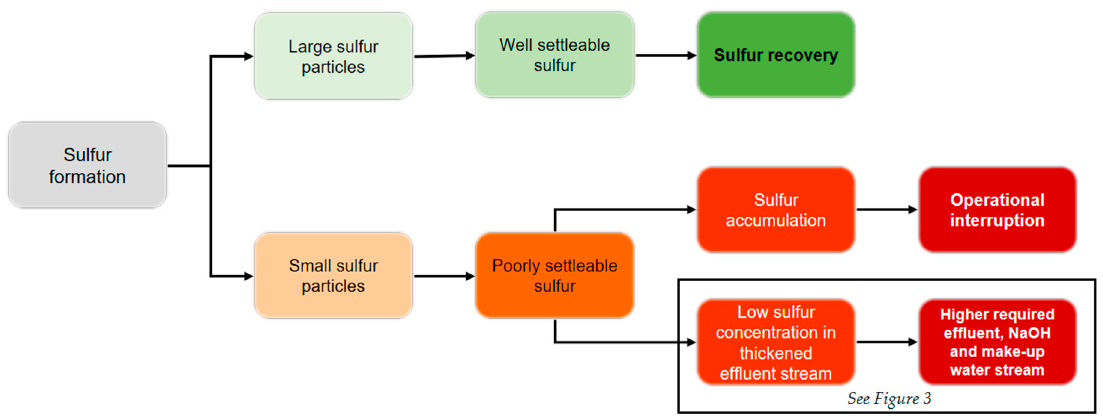
Figure 2. E ff ects of size of sulfur particles on operation of biodesulfurization (BD) process under halo-alkaline conditions.